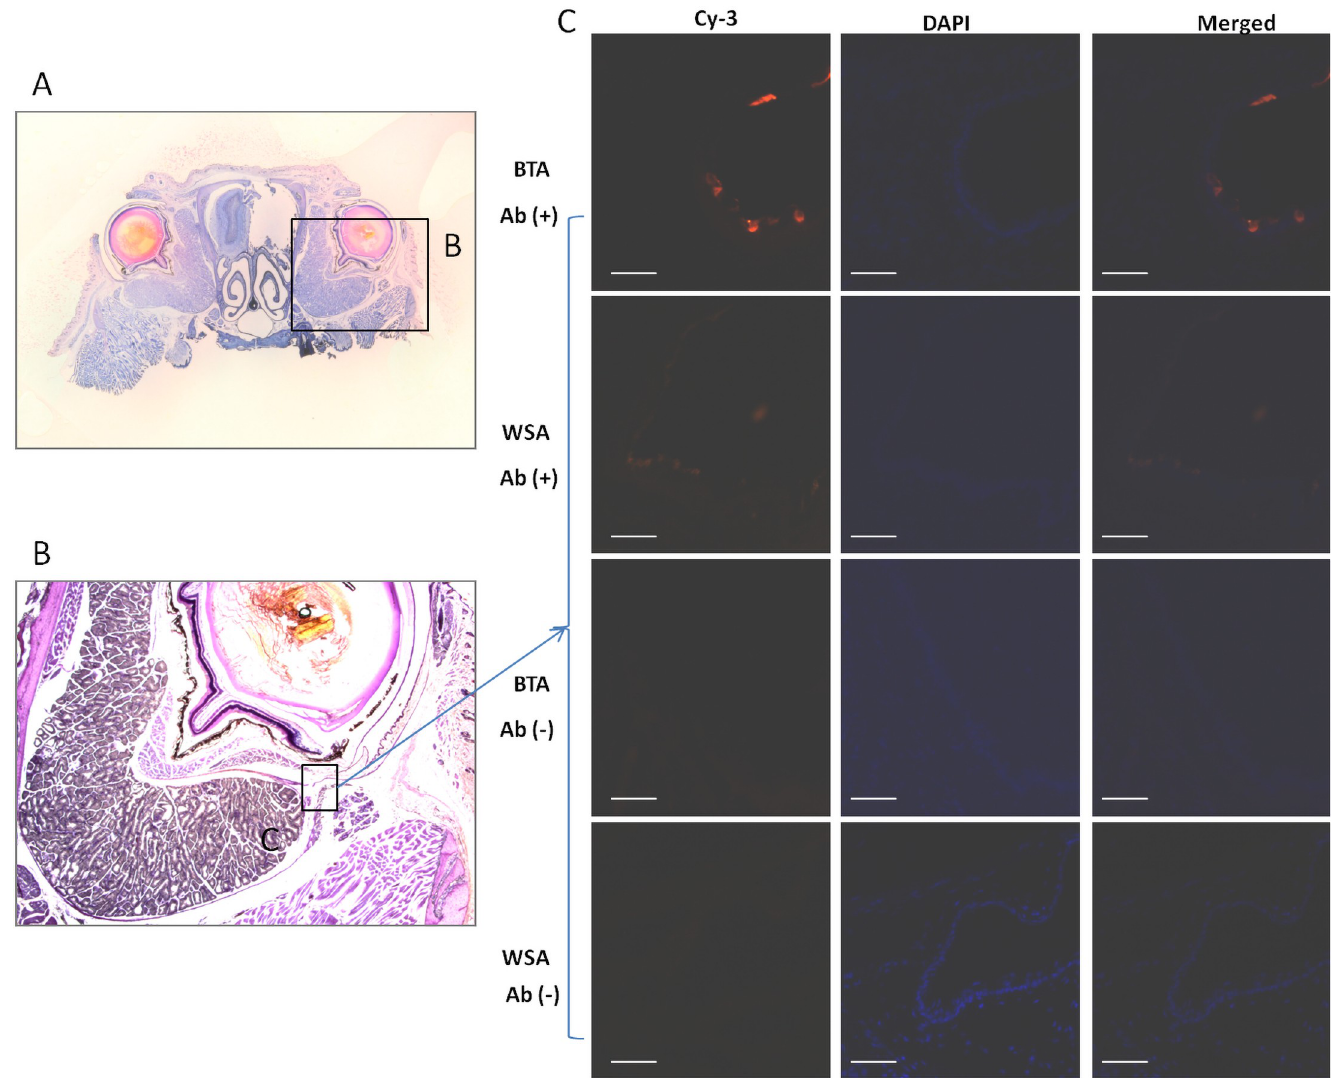
Fig 3. Images of immunostaining for IgG in orbits of native mice. The sections of (A) are collected at the position of Bregma, +3.90 mm. B. The right orbital image magnified in the local of (A) displays a region (inset) of (C), in which the fluorescent images in the right panels (C) were taken. Bars indicate 50 μ m.